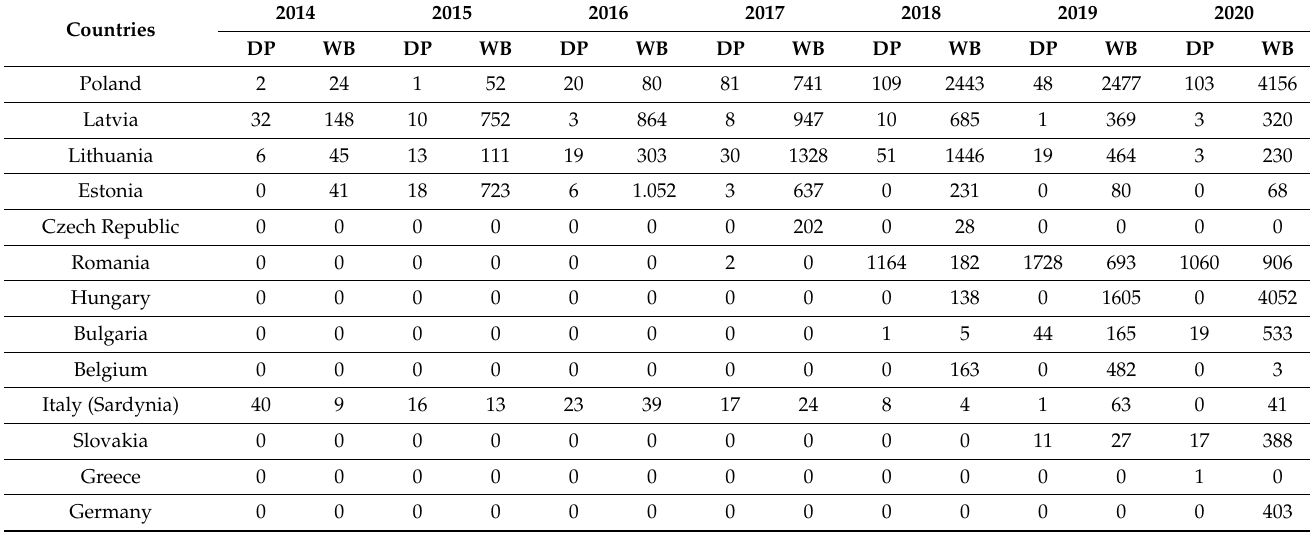
Table 1. ASF cases in wild boars and ASF outbreaks in domestic pigs in EU countries in